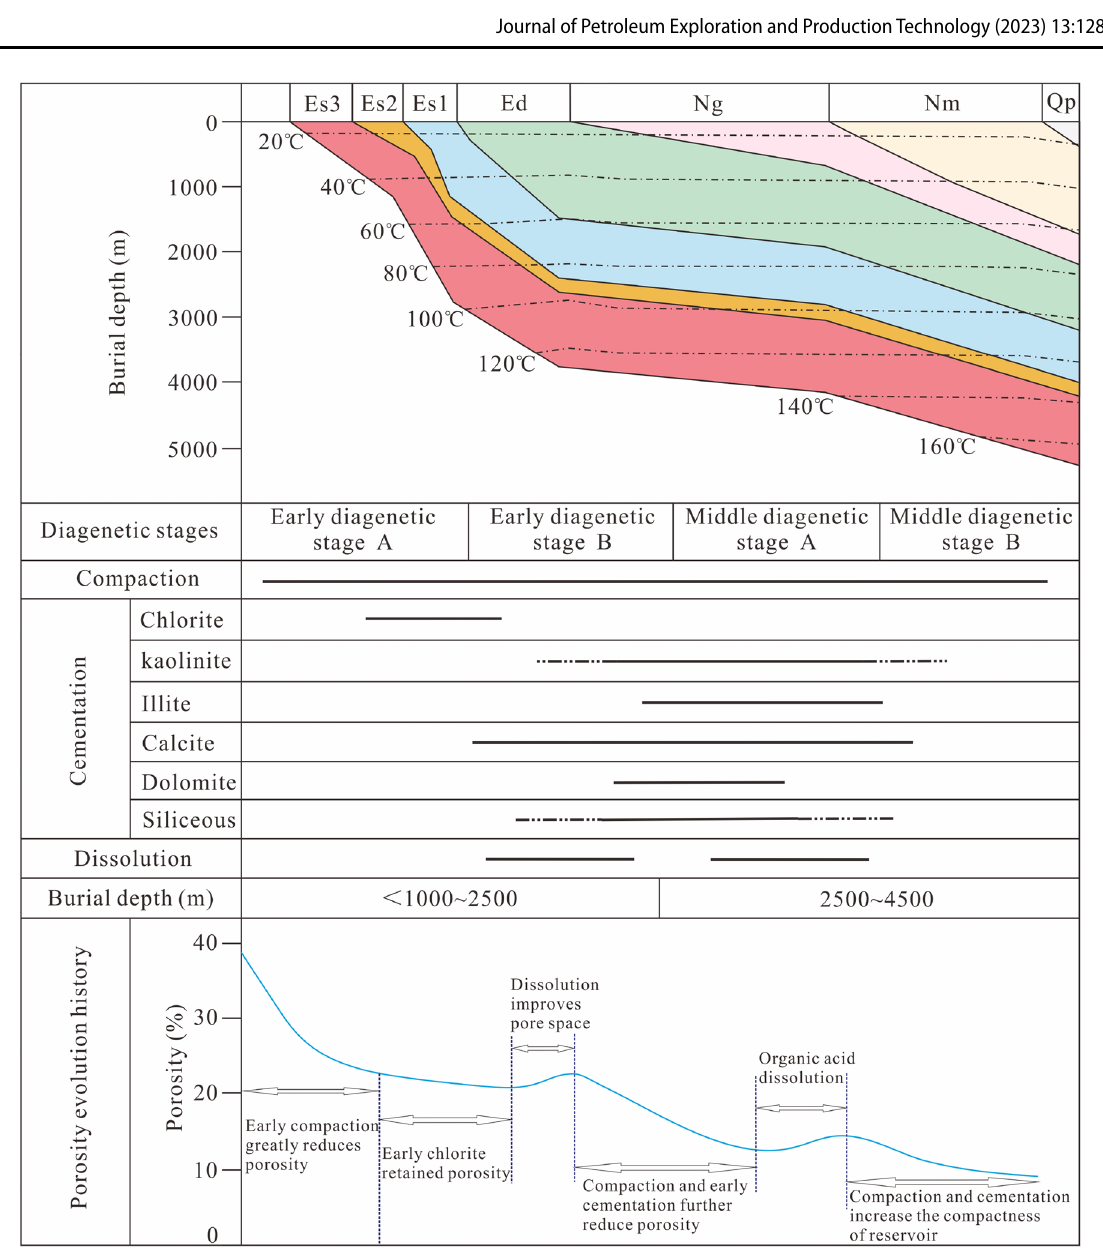
Fig. 14 Diagenetic evolution sequence of the Shahejie Formation